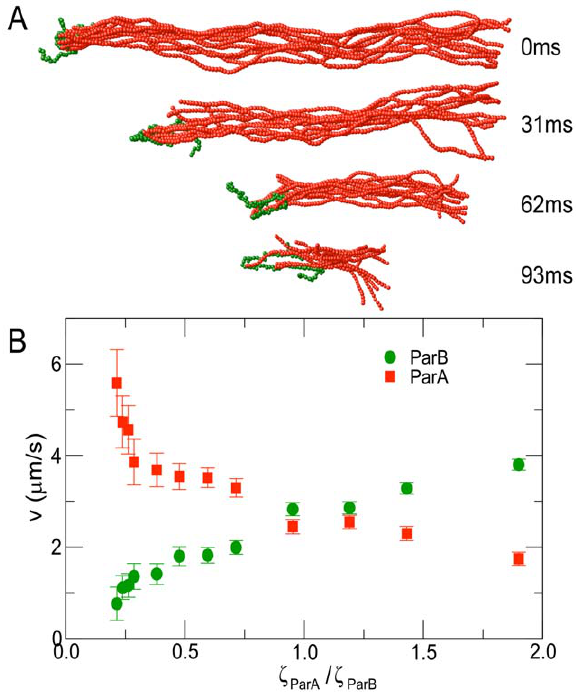
Figure 5. The ParB polymer translocates even when the ParA bundle is unanchored. (A) Snapshots of a simulation in which the ParA bundle is not anchored at its right end (swarmer pole). The ParA bundle (red) is pulled towards mid-cell as the ParB (green) moves towards the swarmer pole. (B) Dependence of speeds of ParA (red) and ParB (green) on the ratio of drags, f ParA = f ParB . In these simulations, f ParB ~ 1 : 1 : 10 { 3 g = s and L ~ 1000nm .